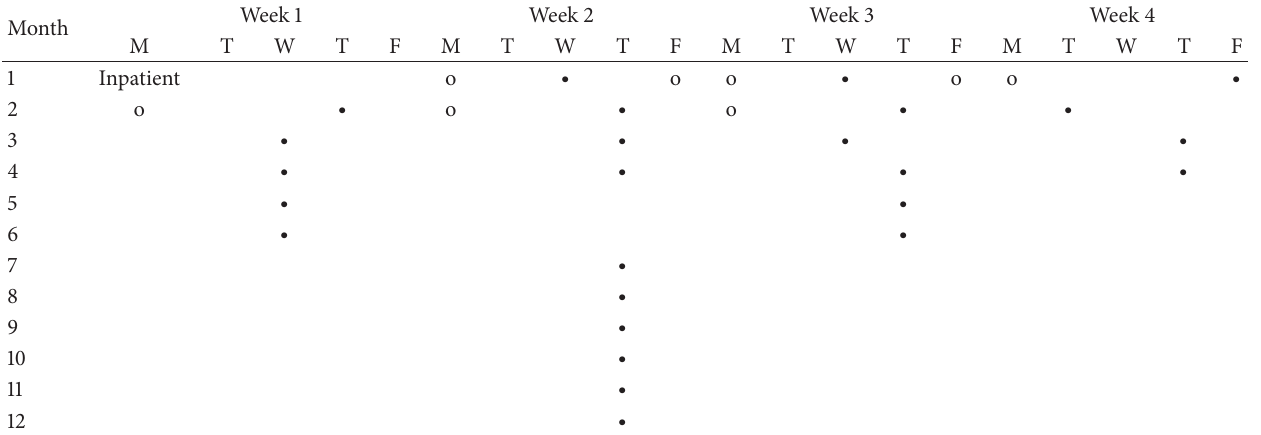
Table 4: Schedule of follow-up outpatient clinic appointments in the first year after kidney or SPK transplantation at Guy’s hospital.